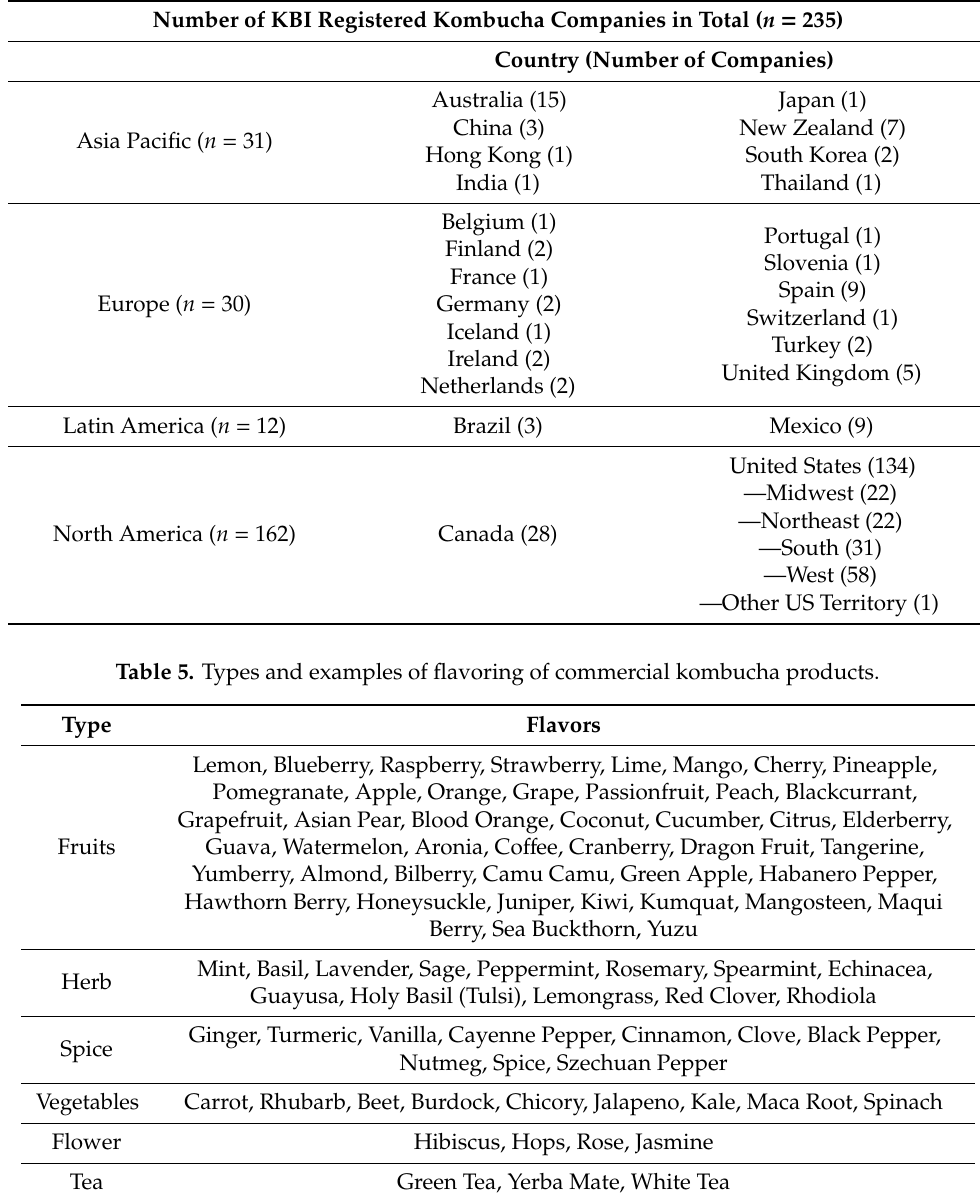
Table 4. Number of kombucha companies registered as a member of Kombucha Brewers International (KBI). This data represents the member states as of November 2019.